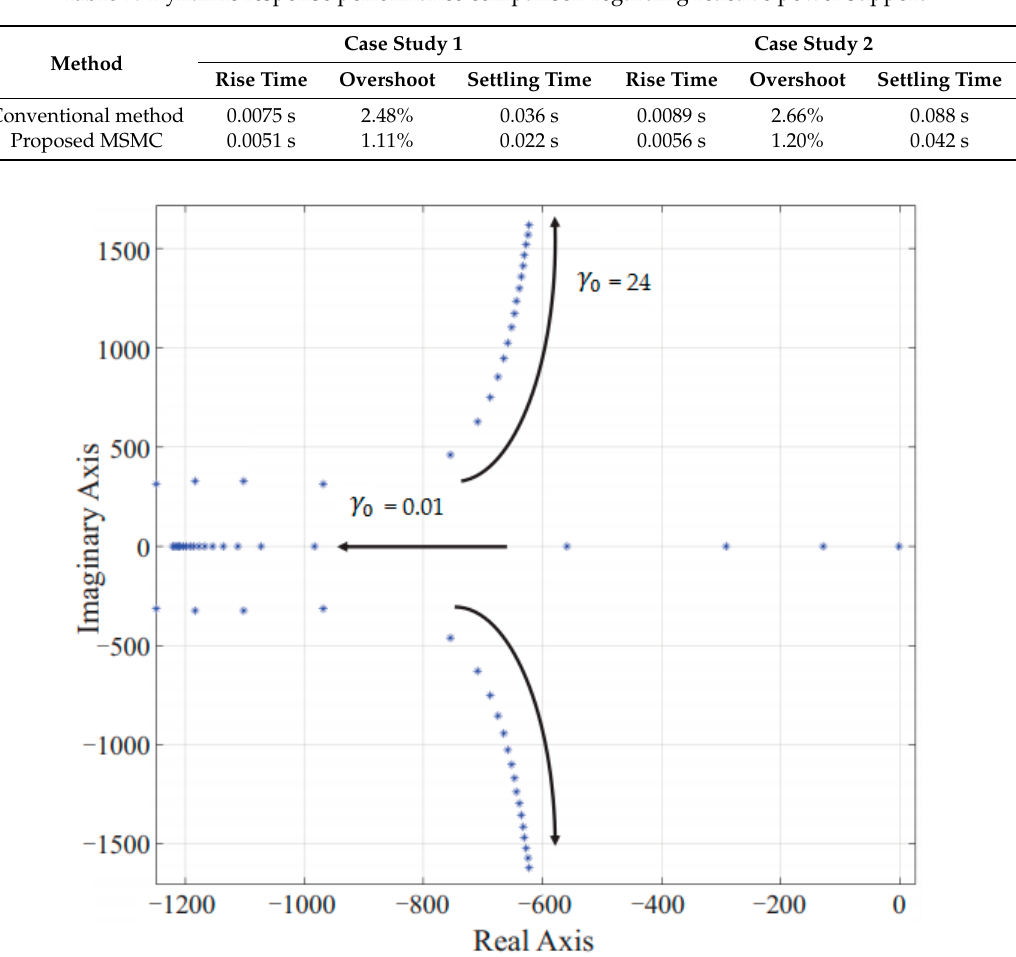
Table 7. Dynamic response performance comparison regarding reactive power support.